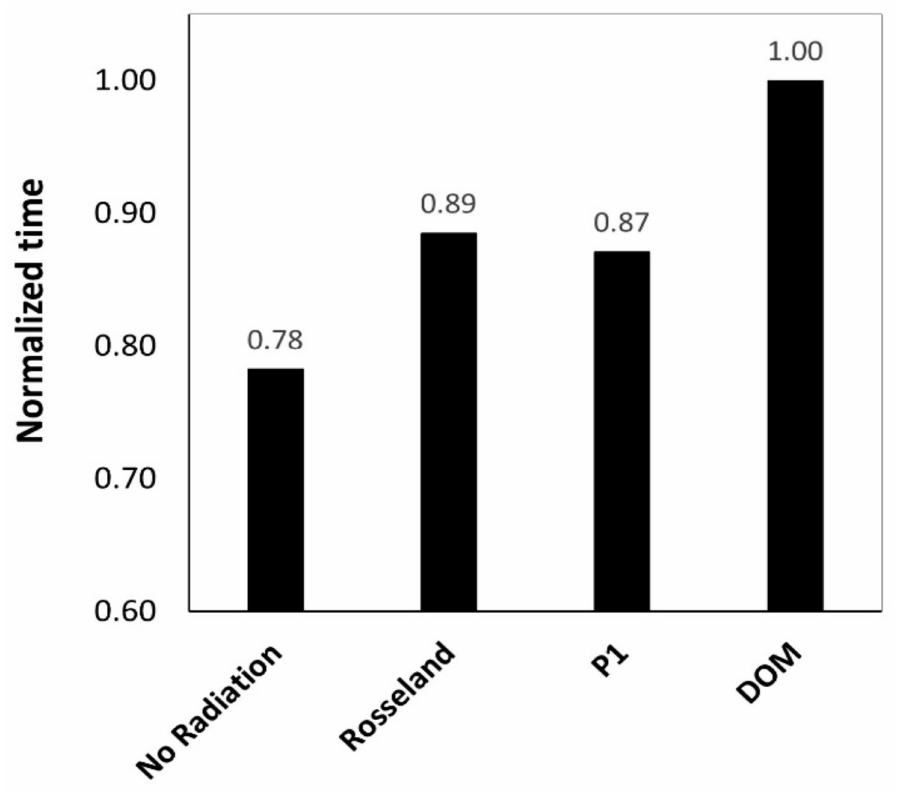
Figure 21. Normalized simulation time for different radiation